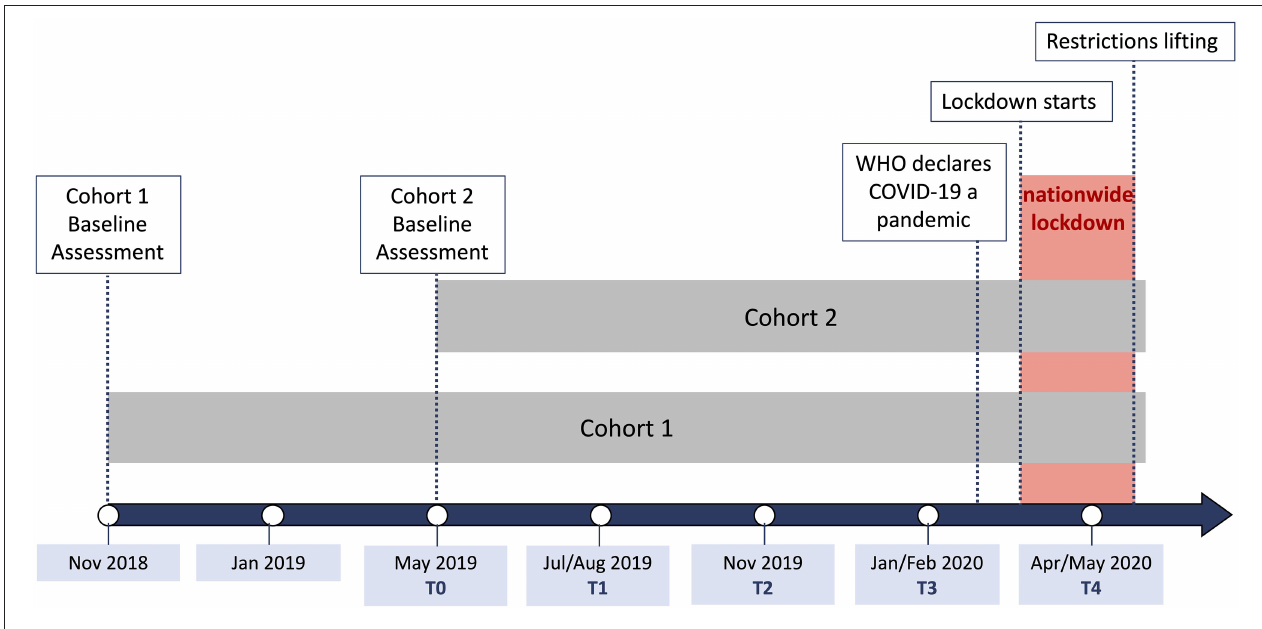
FIGURE 1 | Timing of data